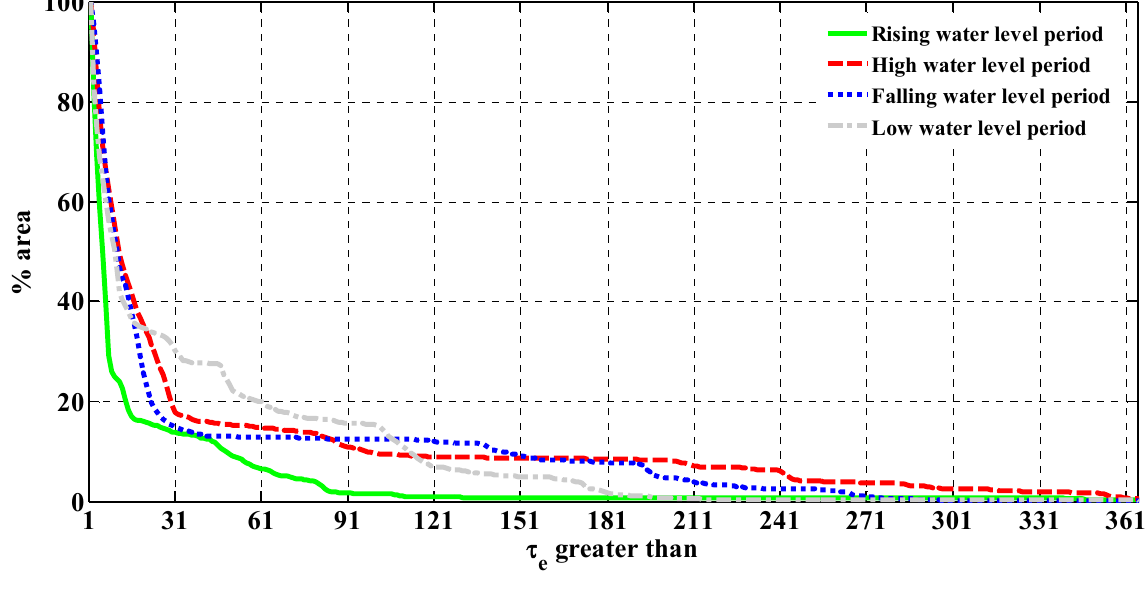
Figure 14. Residence time frequency distribution curves of the four water level regimes obtained from the MIKE 21 hydrodynamic modeling